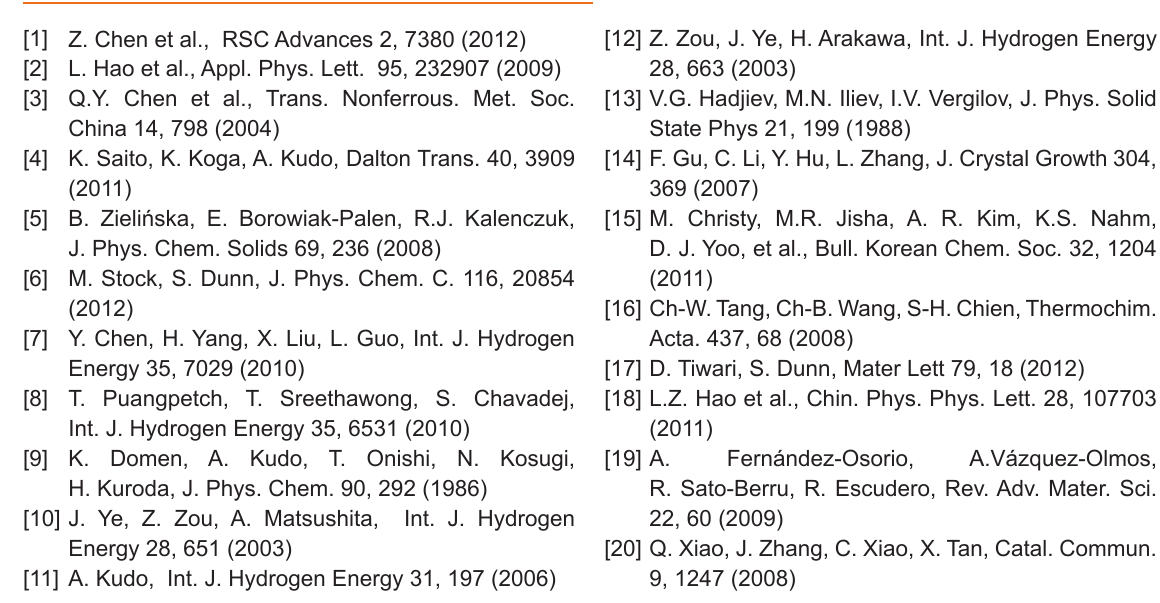
Table 1. Absolute electronegativity, estimated band gap energy, energy levels of calculated conduction and valence bands for Co